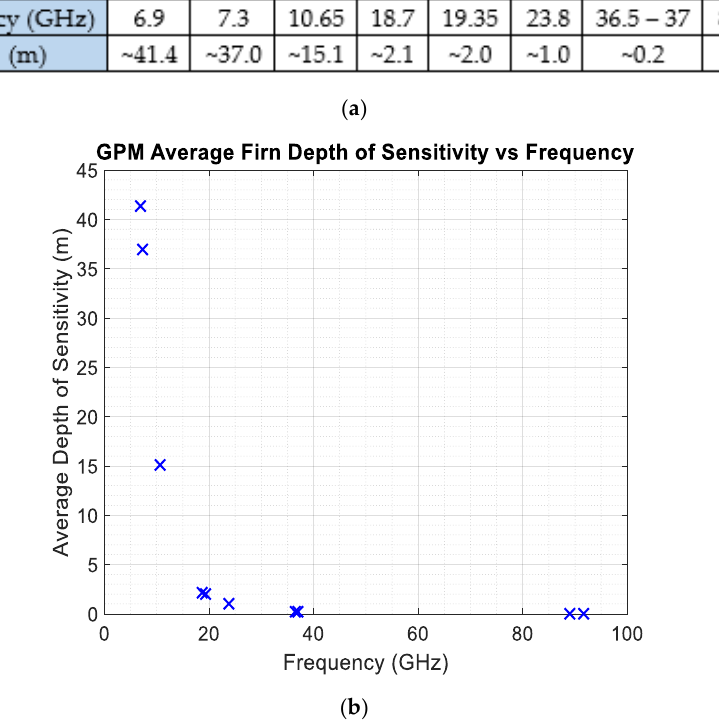
Figure 14. Average firn depths of sensitivity at AMSR2 and SSMIS frequencies and incidence angles as calculated via Equation (20) using the normalized weight functions shown in Figure 13. ( a ) Table illustrating depth sensitivity values; ( b ) plot of average depths of sensitivity versus frequency.